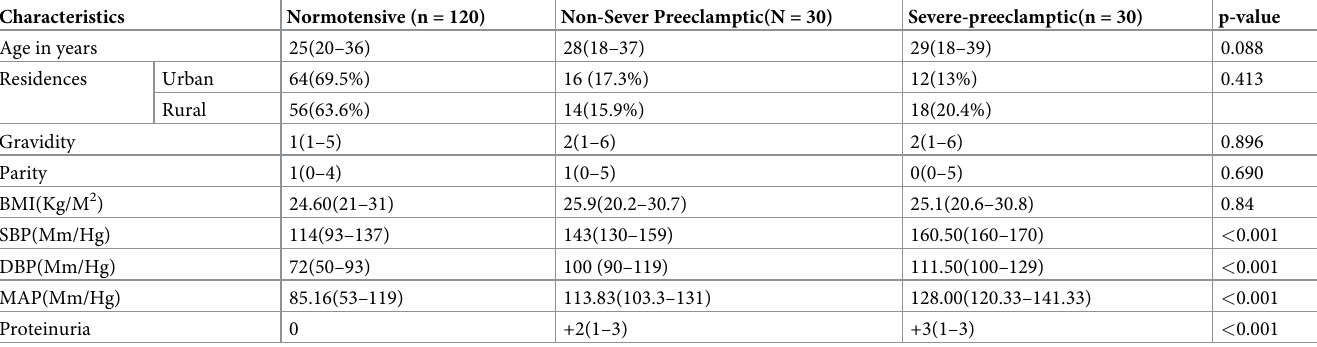
Table 1. Socio-demographic and clinical characteristics of study participants in NEMMCSH from January 1 to April 3, 2019.